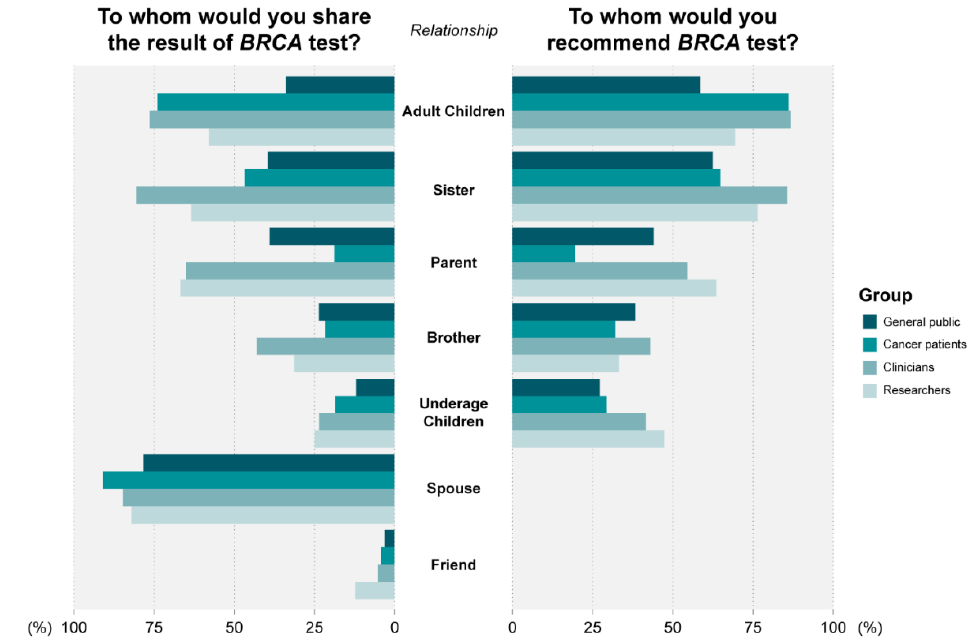
Figure 4. Intent to share BRCA 1/2 test results with family members and recommend testing by respondent type.